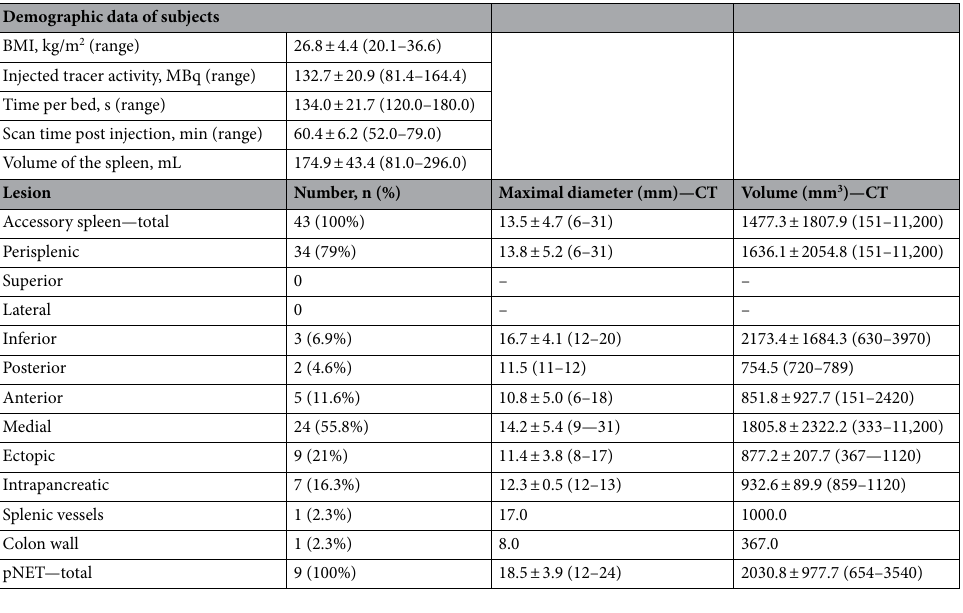
Table 1. Demographic data of study subjects and morphological data of accessory spleens and pNETs (values are given as mean ± standard deviation and range) for the entire cohort of patients (43 accessory spleens, 7 IPAS and 9